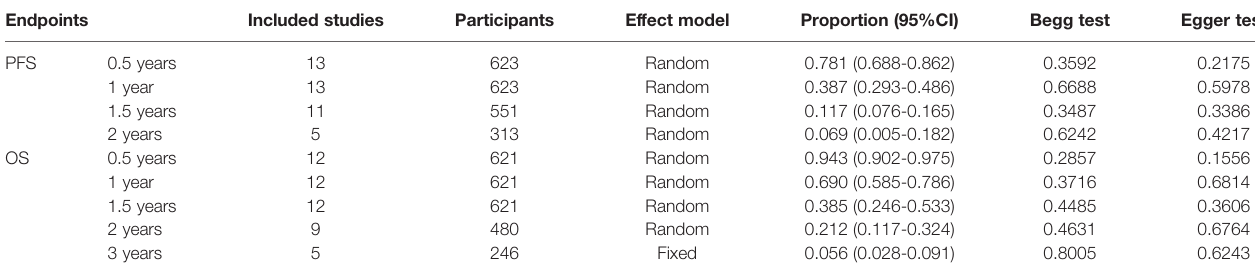
TABLE 3 | Progression-free survival and overall survival of included studies.